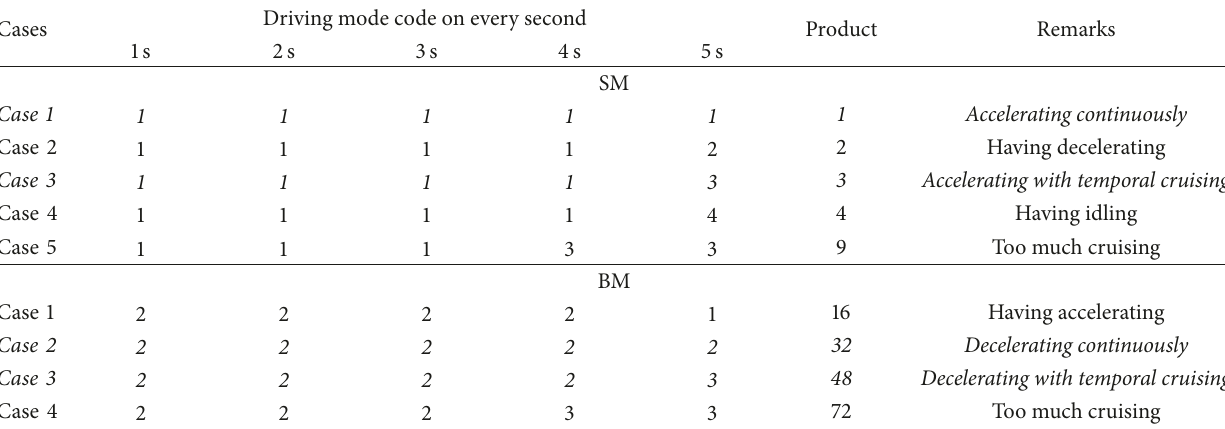
Figure 5: RMF of speed. Table 1: Enumeration of the product of driving mode codes in SM and BM.